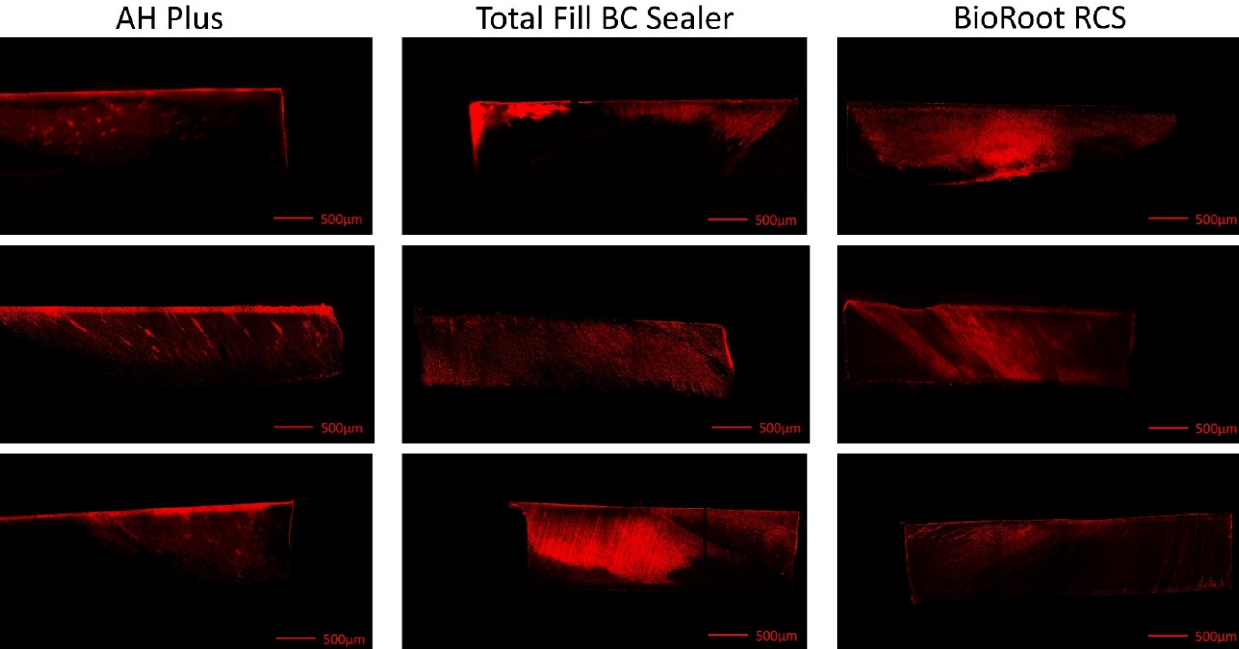
Figure 2. Confocal laser scanning microscope (CLSM) images of root specimens showing passive penetration of leached rhodamine B dye from AH Plus, Total Fill BC Sealer, and BioRoot RCS ( n = 3 per sealer) into dentinal tubules. The sealers mixed with rhodamine B were placed on the top surface. Rhodamine B leached into the dentinal tubules and stained the dentinal tubules red.